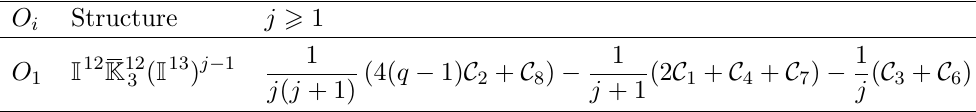
( QO ) J ( QO ) when QO h i